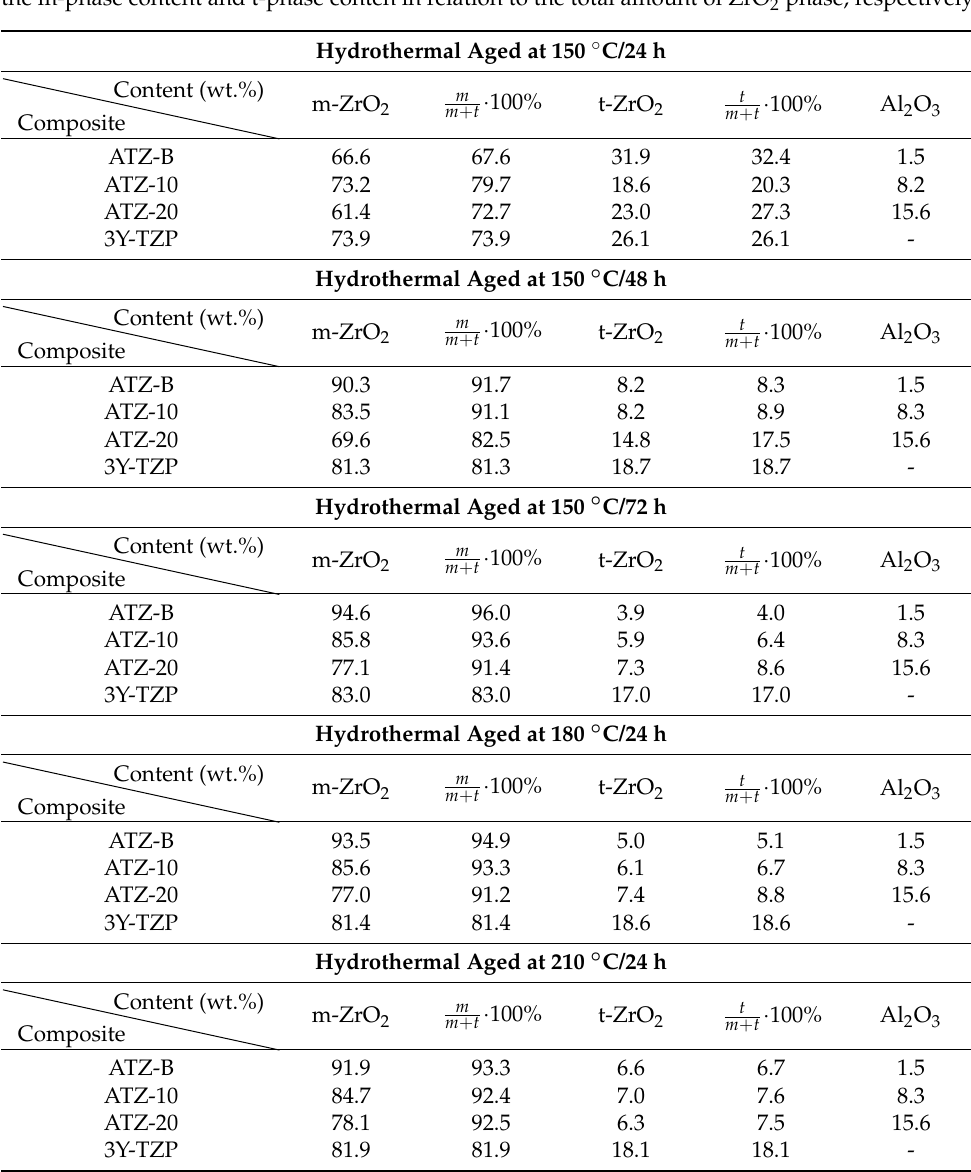
Table 5. Phase content of the ATZ composites and 3Y-TZP reference material after hydrothermal treatment under selected conditions estimated by Rietveld refinement. m/(m + t) and t/(m + t) are the m-phase content and t-phase conten in relation to the total amount of ZrO 2 phase, respectively. Hydrothermal Aged at 150 ◦ C/24 h CompositeContent (wt.%)